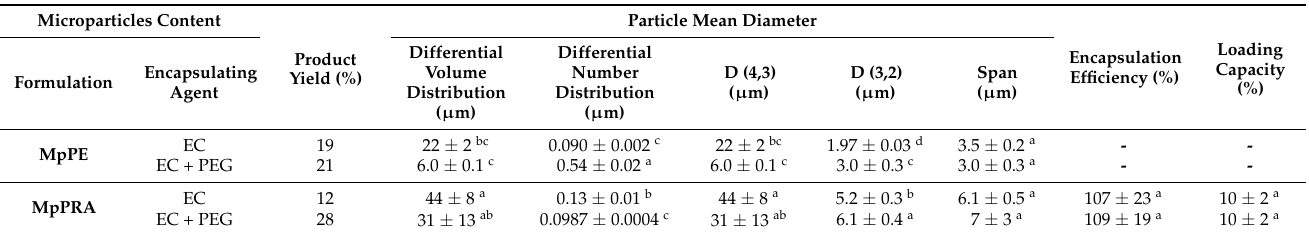
Table 1. Characterization of polymer-based microparticles for RA encapsulation: product yield, particle diameter, encapsulation efficiency, and loading